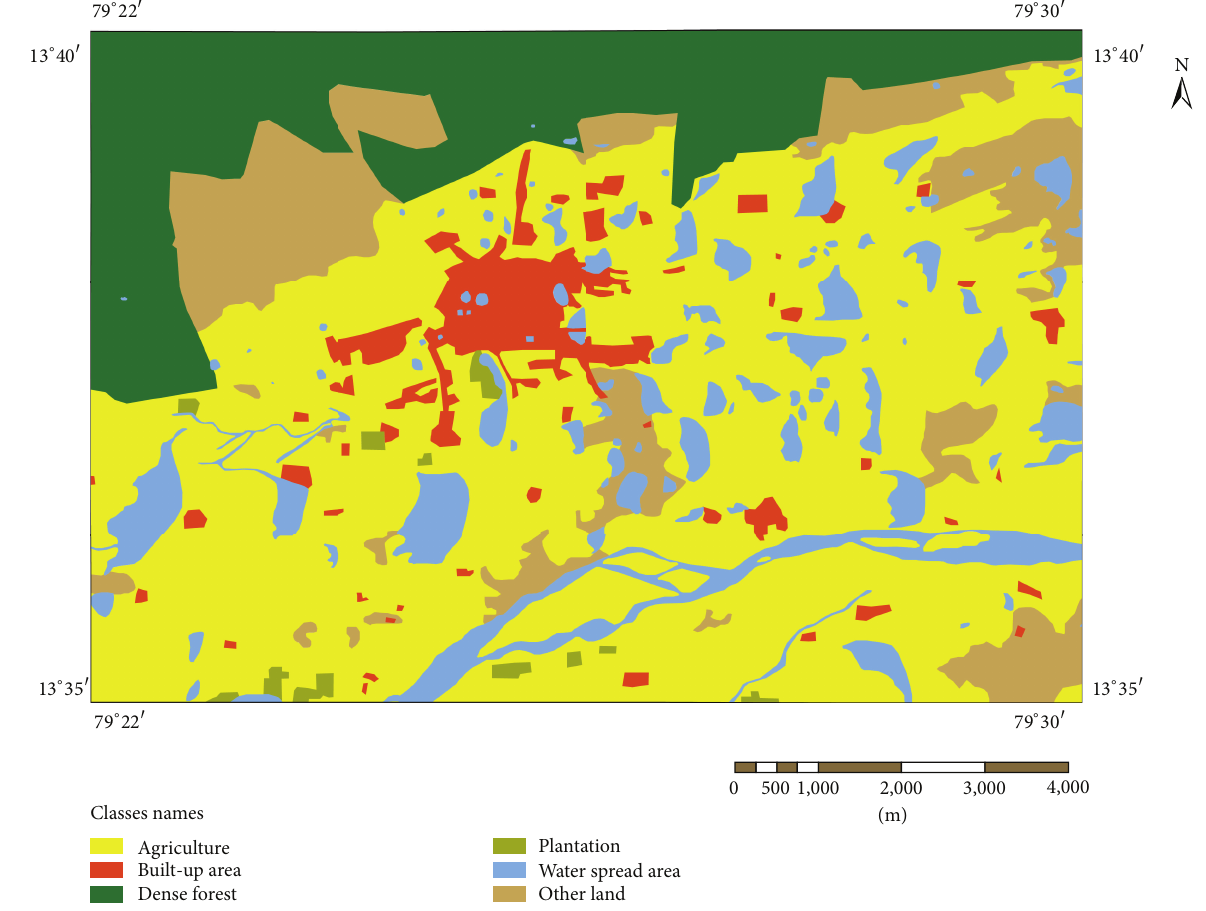
Figure 3: Land use/land cover in